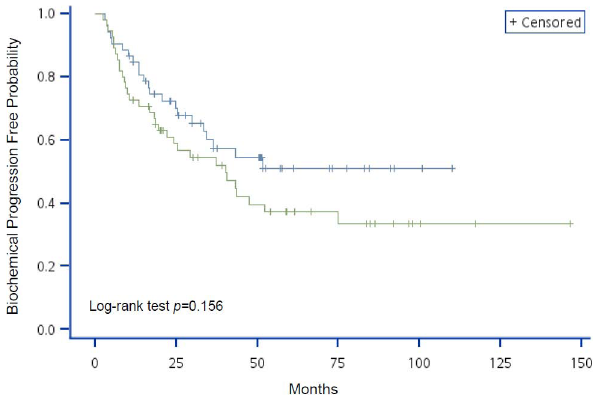
Figure 2. Kaplan-Meier analysis of BCP-free probability for advanced prostate cancer patients by risk group using age. The blue line represents age $ 74 y and the green line represents age , 74 y. P -value of Log-rank test=0.156.